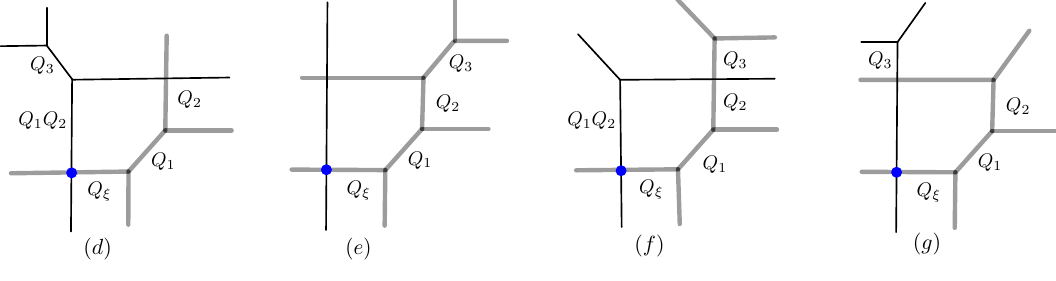
Figure 15 . Some equivalent double layer brane webs for U(1) 0 + 2 F + 2 AF